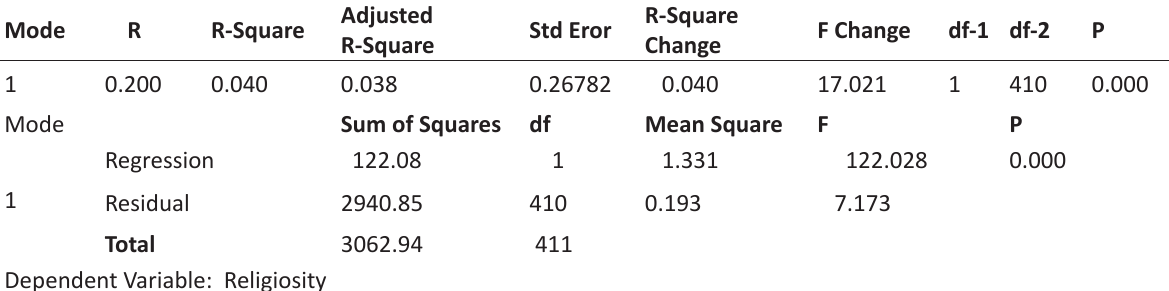
Table 8. Regression